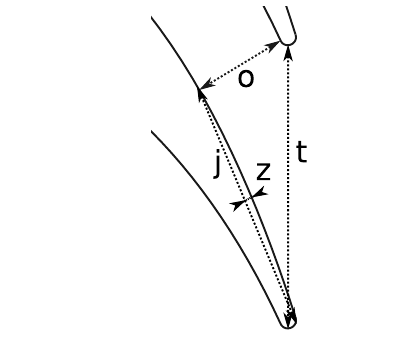
Fig. 3. Mean radius of curvature of the suction side for outflow angle